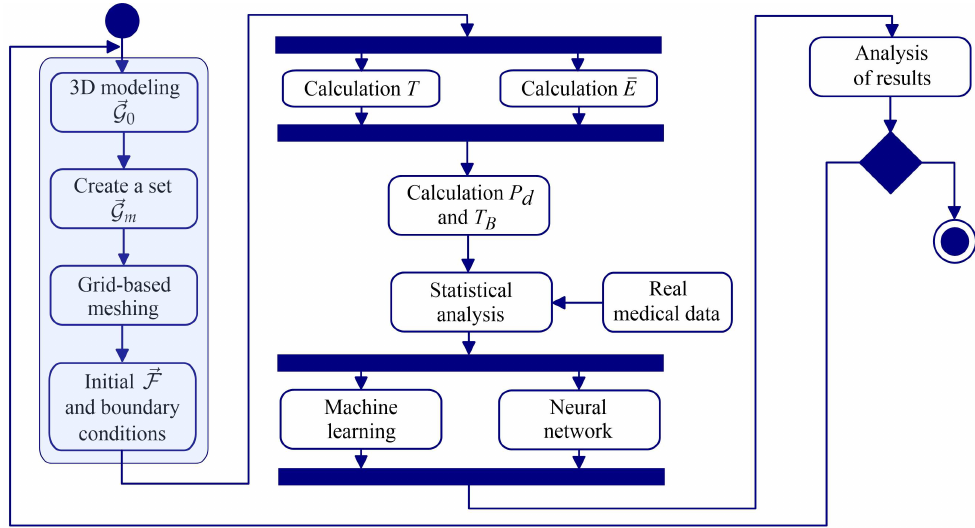
Figure 12. Algorithm for conducting a series of computational experiments for a large sample of breast models and processing temperature data using artificial intelligence